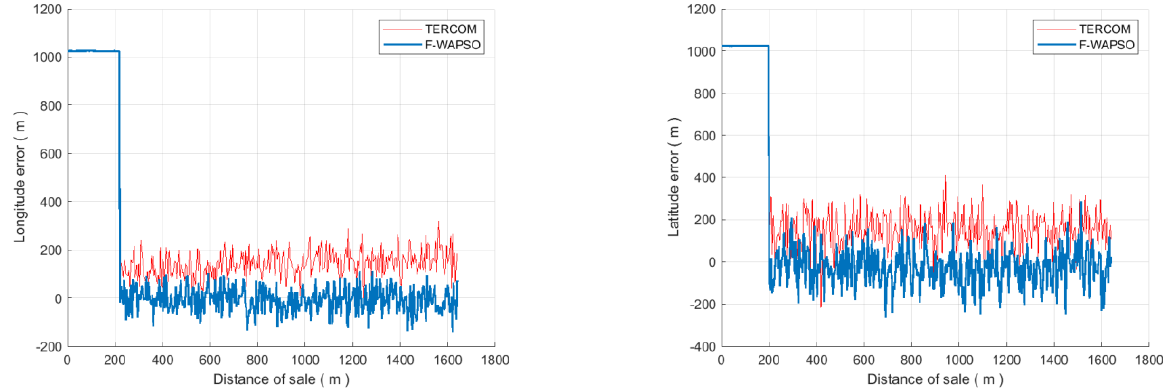
Figure 7. Longitude and latitude error curves of trajectory B.